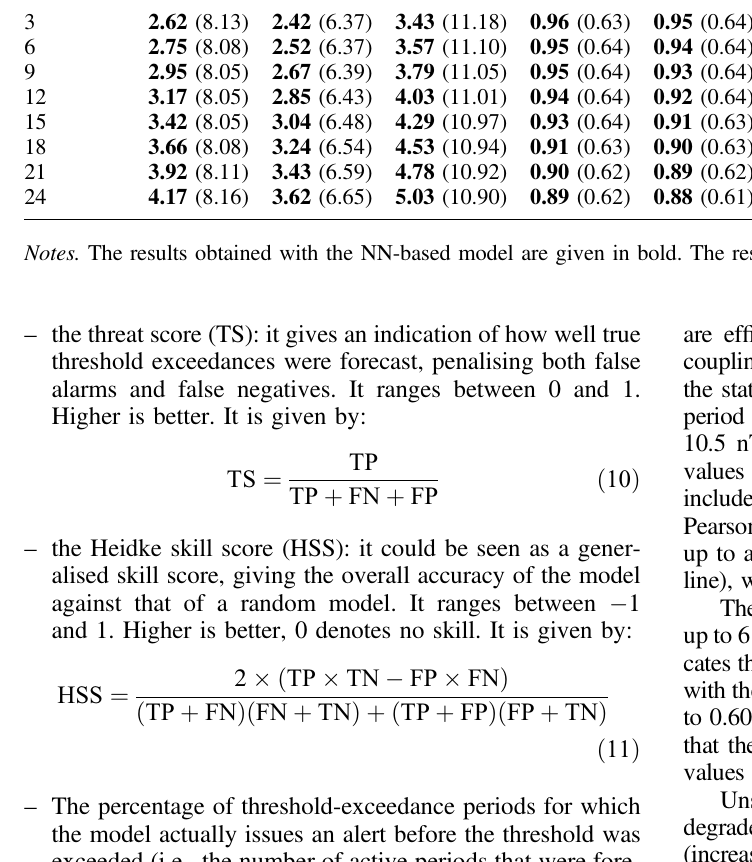
Table 2. Evaluation of the NN-based and the baseline models in the context of the regression problem. The model was evaluated with the full test set and also with the SIR-induced test set and the ICME-induced test set. Time horizon